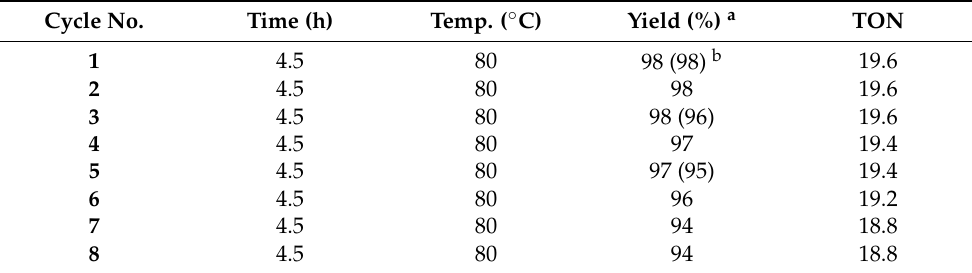
Table 8. Recycling results of B -catalyzed phospha-Michael addition of diisopropyl phosphite ( 1a ) with 2-(4-methylbenzylidene)malononitrile ( 4 ). Cycle No.